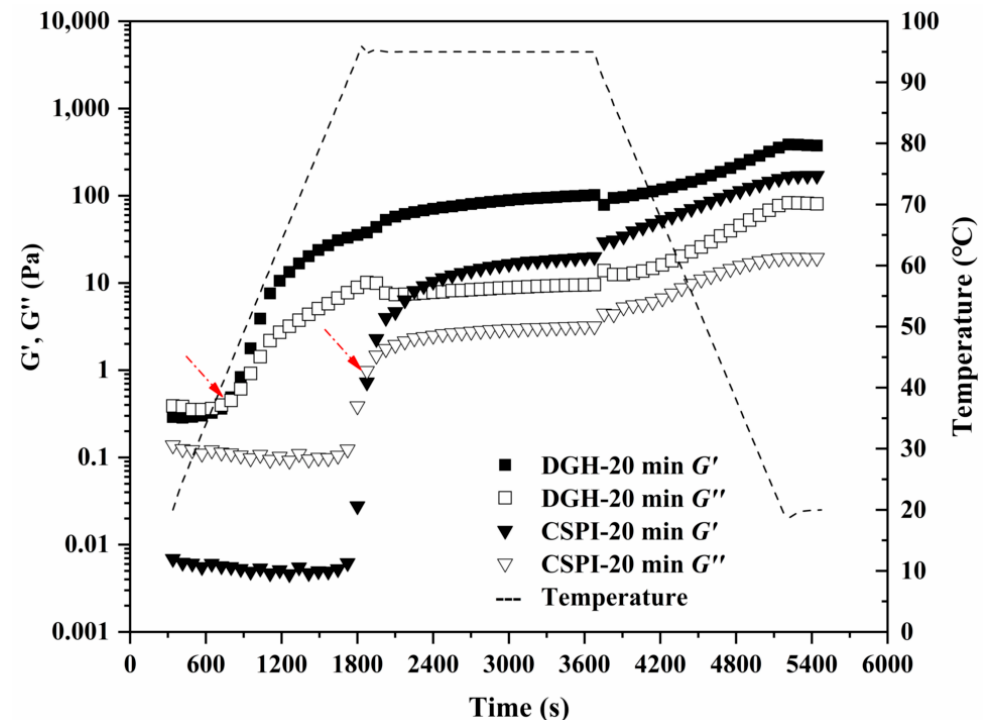
Figure 8. The thermal gelation profiles of DGH (rectangle) and CSPI (triangle) after being treated by HIU for 20 min. The solid symbols indicate G ′ , while the open symbols indicate G ″ . The red arrow indicates the onset gelling point.